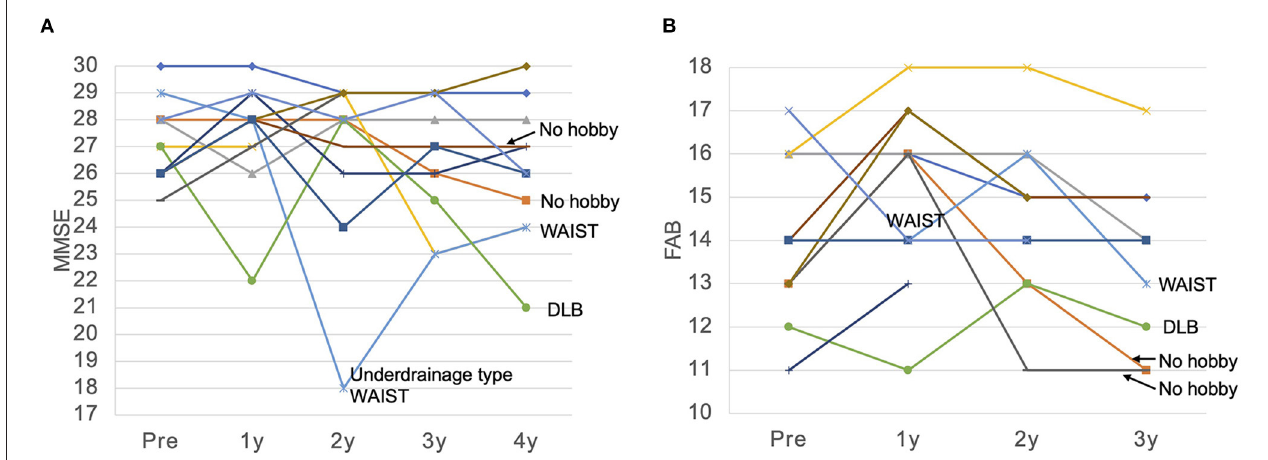
FIGURE 4 | MMSE (A) and FAB (B) for each patient over 4 years. (A) The MMSE remained almost unchanged for 4 years in many patients. MMSE showed a significant decrease in cases of dementia with Lewy bodies (DLB) and functional underdrainage associated with weight gain, which we named weight and abdominal pressure induced shunt trouble (WAIST). (B) FAB was also maintained at a high score for 4 years in many patients, but declined significantly in one patient who developed DLB, in two patients with no hobbies and a persistent inactive lifestyle, and in one patient with an underdrainage type of WAIST. MMSE, Mini-Mental State Examination; FAB, Frontal Assessment Battery; WAIST, weight and abdominal pressure induced shunt